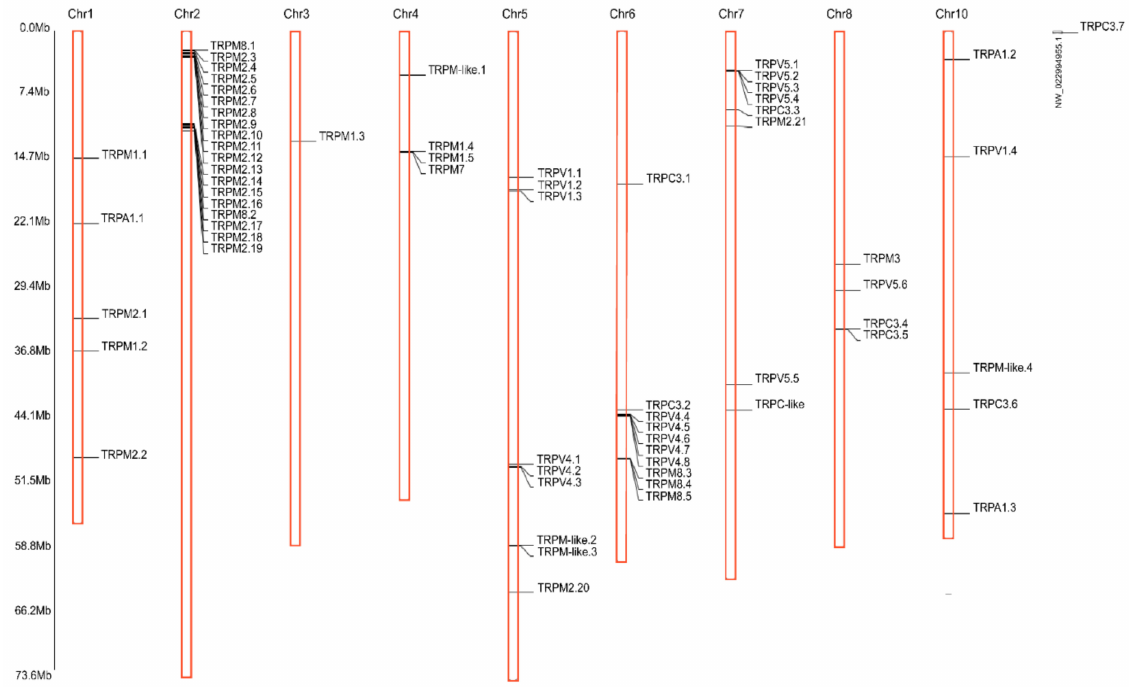
Figure 1. Identification of TRP genes and their distribution across chromosomes of C. gigas . The scale on the right is in million bases (Mb). Chromosome numbers are shown at the top of each vertical bar. Genomic locations of TRP genes are marked with the black